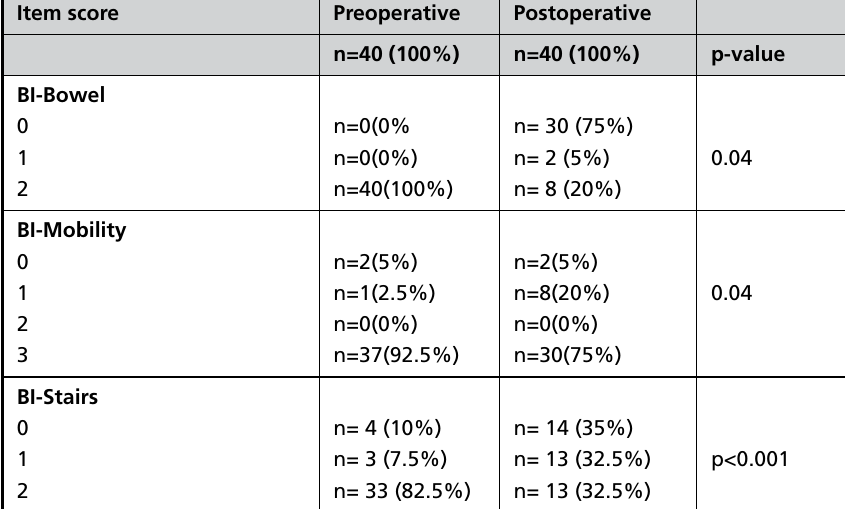
Table 3: Comparison of pre and postoperative BI item scores (n=40) Item